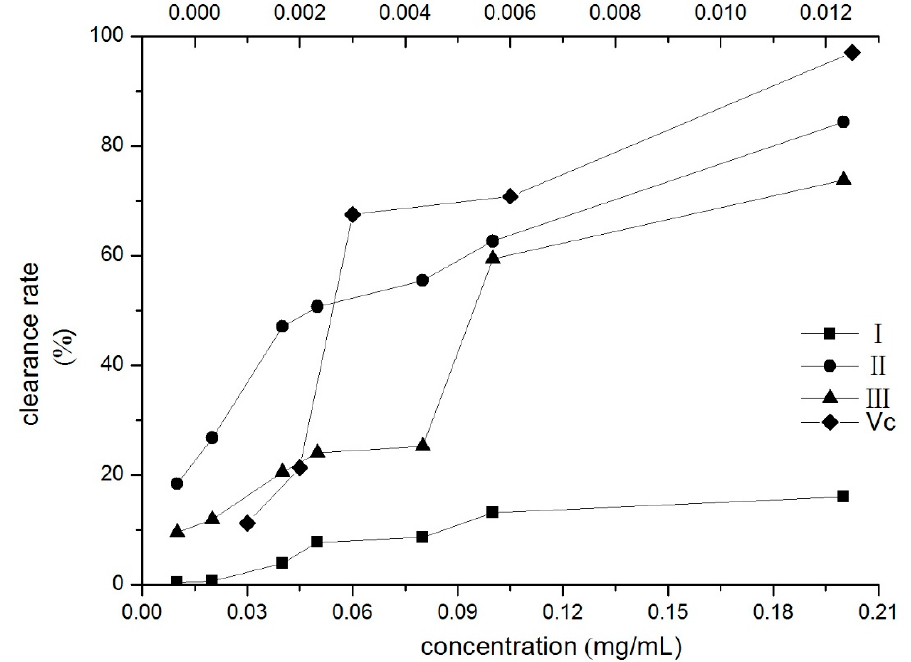
Figure 5. Scavenging effects of three compounds on DPPH assay (the upper horizontal axis was I: β -D-glucopyranose 1-[(E)-3-(4-hydroxyphenyl)-2-propenoat], II: β -D-glucopyranose 1-[(E)-3-(3, Vc’s). Ι : β -D-glucopyranose 1-[(E)-3-(4-hydroxyphenyl)-2-propenoat], ΙΙ : β -D-glucopyranose 1-[(E)- 4-dihydroxyphenyl)-2-propenoat], III: 3-(3, 4-dihydroxyphenyl)-2-propenoat], ΙΙΙ : 1-O-sinapoylglucopyranoside.